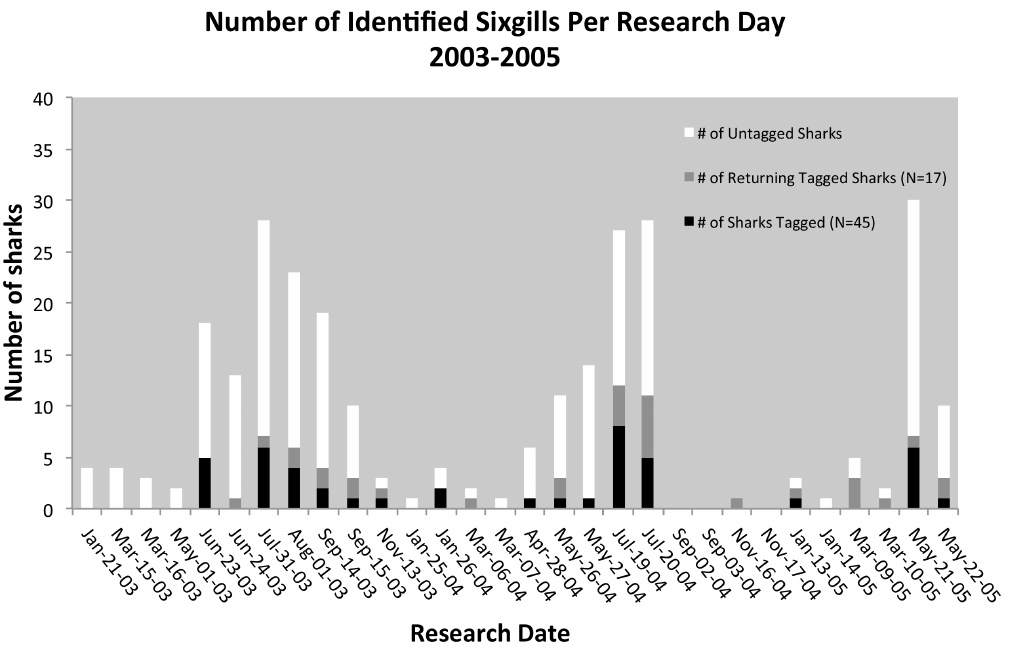
Figure 3. Number of Sixgills Identified on Each Research Day by Sighting Type (Untagged Shark, Newly Tagged Shark, Returning Tagged Shark).